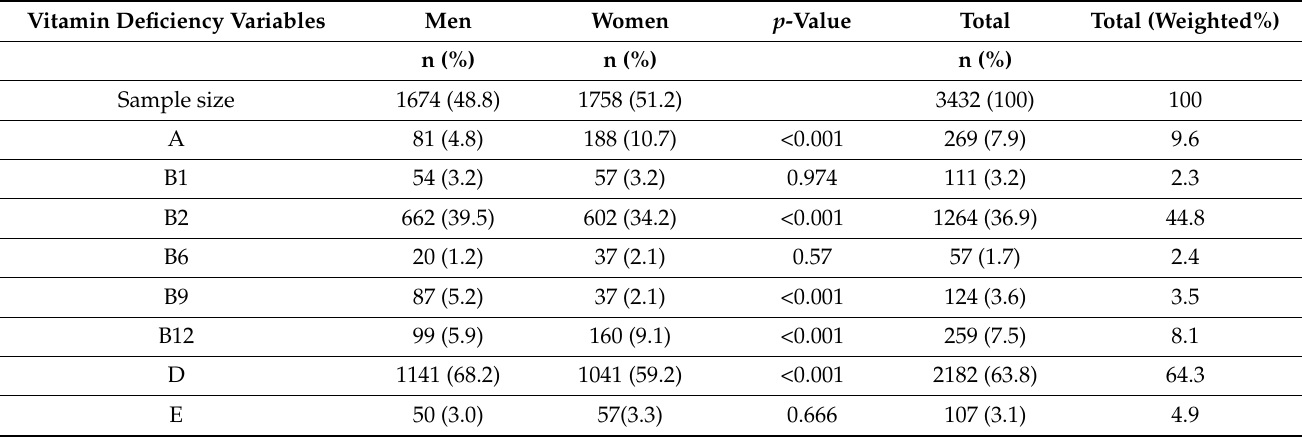
Table 2. Prevalence of vitamin deficiencies among Saudi